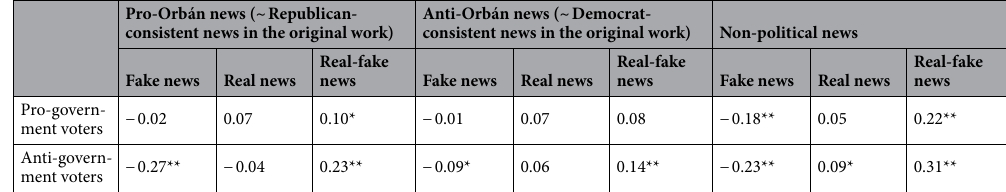
Table 1. Correlation between CRT and the accuracy of judgments. Real-Fake News = Media truth discernment. Pro-Orbán news = Pro-government news, Anti-Orbán news = Anti-government news. We did not use both the expressions of pro-government / anti-government news and pro-government / anti-government voters at the same time for the sake of clarity and easy understanding. Negative correlations in the fake and real columns mean that the more analytic people are, the less accurate they find that specific type of news. Positive correlations in the media truth discernment column indicate that the more analytic individuals are, the better they can distinguish fake news from real ones. Statistical significance is indicated at the following levels: *** p < 0.001; ** p < 0.01; * p <